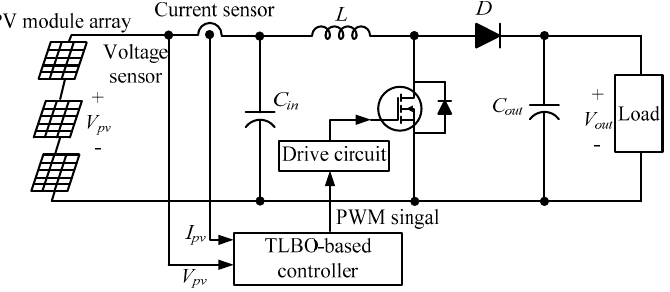
Figure 2. Architecture of the proposed maximum power point trackers (MPPT). Table 1. Specifications of the primary components of the DC/DC boost converter.